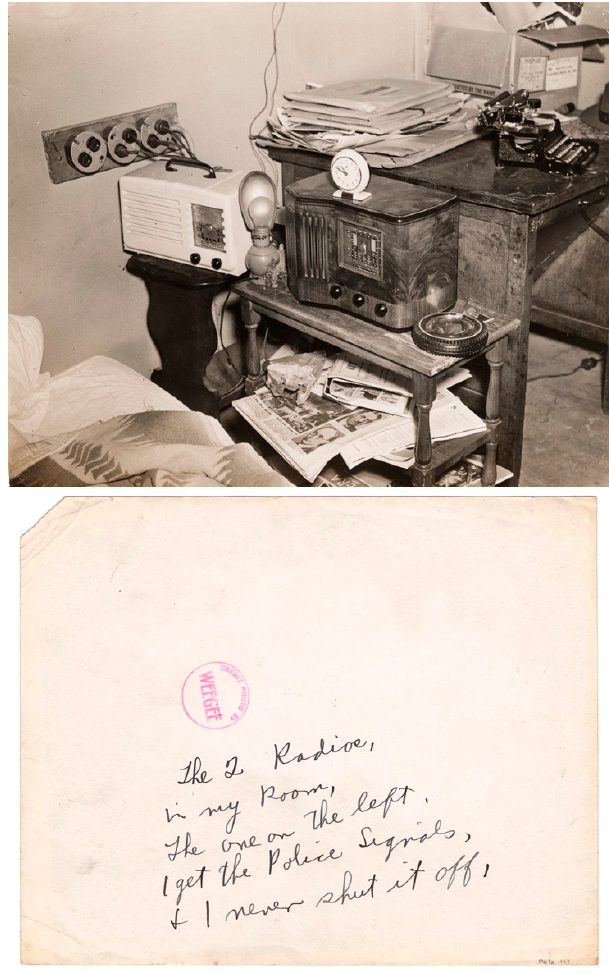
Figure 8. Weegee, [Police radio in Weegee’s room, New York], recto and verso, ca. 1941. © Weegee/International Center of Photography (19632.1993).